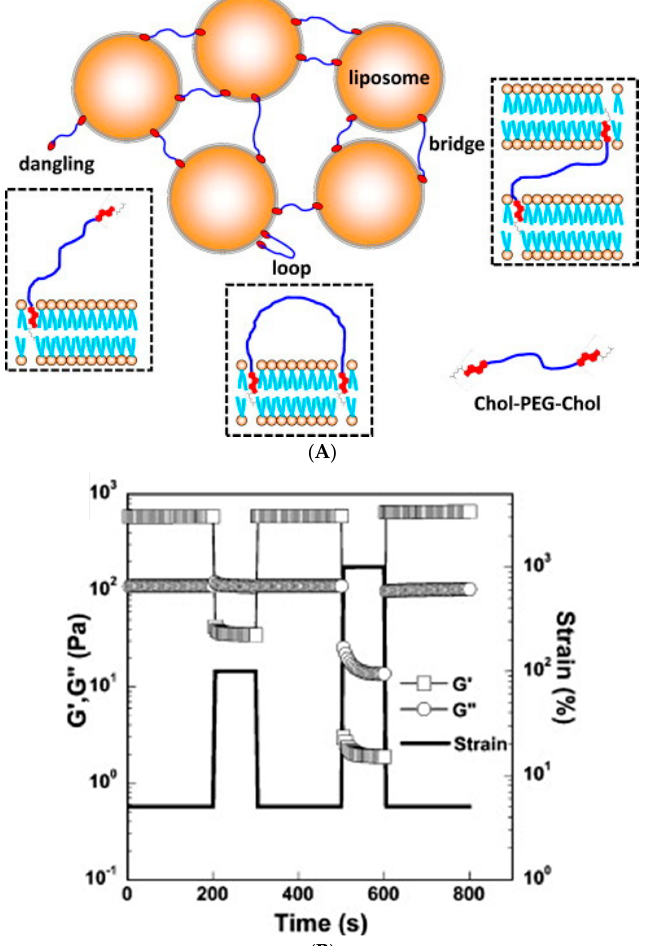
Figure 4. ( A ) Schematic illustration of liposome gel. Cholesterol end groups of Chol-PEG-Chol were embedded in the liposome bilayers, forming bridge, loop or dangling; ( B ) Evolution of storage G ′ ( □ ) and loss modulus G ″ ( ○ ) of liposome gel with time following two successive pulses of high deformation (solid line). Reprinted with permission from [87]. Copyright 2016